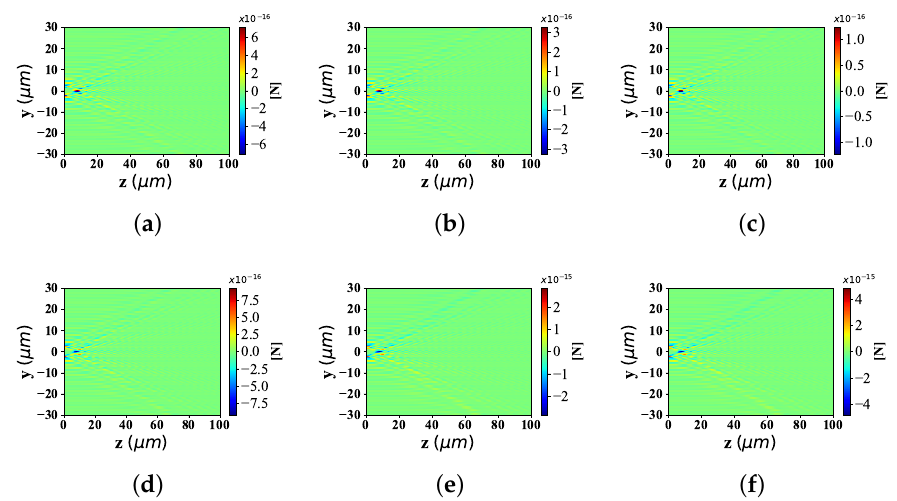
Figure 10. Distribution of F y under different refractive indic ( m 1 = 1.0, 1.2, 1.3, 1.8, 2.8, 3.8) for the interaction of Bessel pincer light-sheets beam on the spherical particle. ( a ) m 1 = 1.0; ( b ) m 1 = 1.2; ( c ) m 1 = 1.3; ( d ) m 1 = 1.8; ( e ) m 1 = 2.8; ( f ) m 1 =